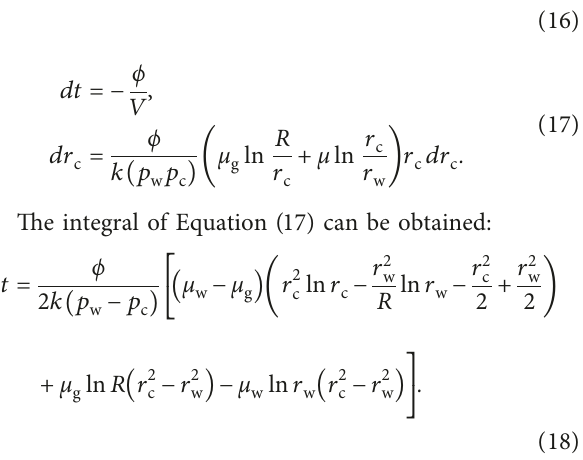
Figure 7: Mechanics model of water injection into the coal